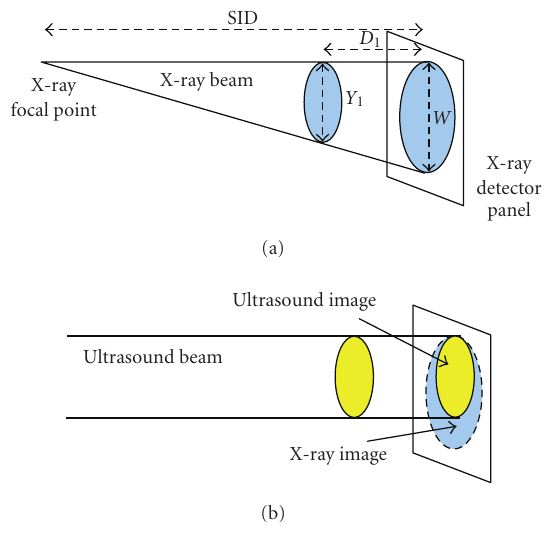
Figure 2: Schematic of beams and target coverage areas in (a) X- ray; (b)